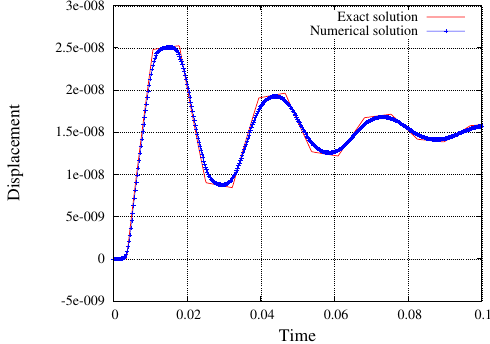
Figure 3. Time history for an accurate enough approximation of the analytical solution and a numerical solution for displacements, obtained by scheme (2.7) for the column problem with N = M = 400 at node x = 0 . 5.